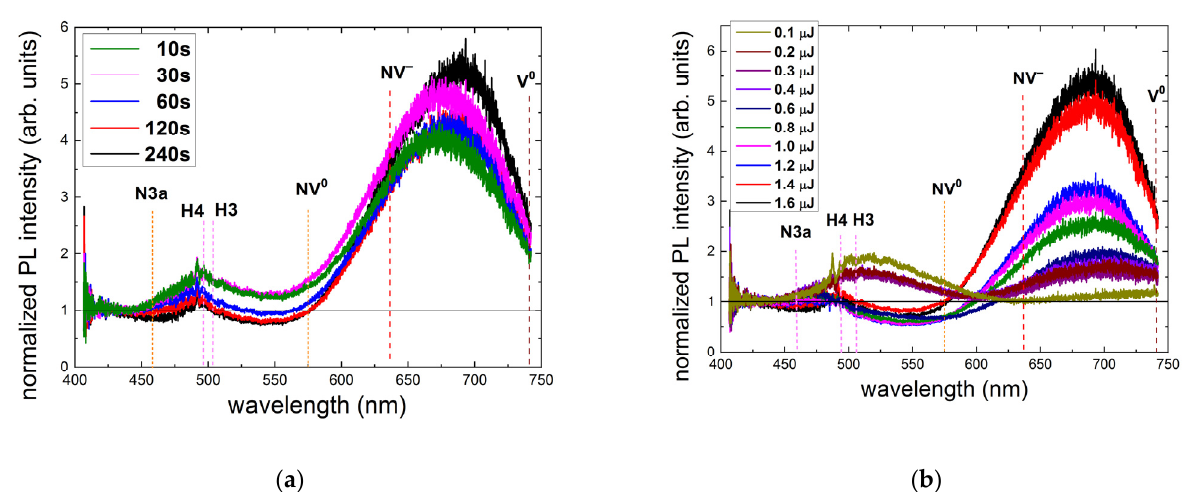
Figure 6. RT ( a ) and LNT ( b ) 405 nm PL spectra of the background and micromarks, as well as their normalized intensity ( c ) for an exposure time of 240 s (24 M pulses) and an incident 0.3 ps laser pulse energy of 1.6 μ J. Spectral assignment after [5].